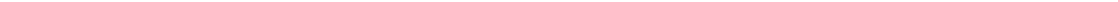
Table 1 (sim1). Observed false positive rates from a differential gene expression analysis using edgeR applied to various count matrices (with a nominal p-value cutoff at 0.05), limited to genes with true underlying differential isoform usage (recall that no genes are truly differentially expressed in this data set). The results are stratified by “effect size” (the difference in relative abundance between the two differentially used isoforms) and the length ratio between the longer and the shorter of the differentially used isoforms. FPRs below the nominal p-value threshold (0.05) are marked in bold. For more details, see Data set 1. simplesum featureCounts simplesum_avetxl